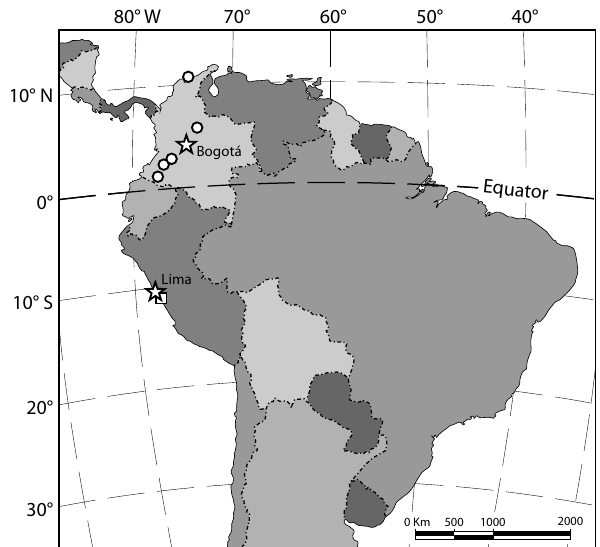
Figure 1. Map of South America indicating the six locations in Colombia reported by Caldas (1809) where the stratospheric aerosol veil had been observed from 11 December 1808 (circles: Pasto, Popayán, Neiva, Santa Marta, Tunja). The square shows the loca- tion of the district of Chorrillos, Lima, Peru, where after-glows were observed following sunsets from mid-December 1808 to Febru- ary 1809 as reported by Unanue